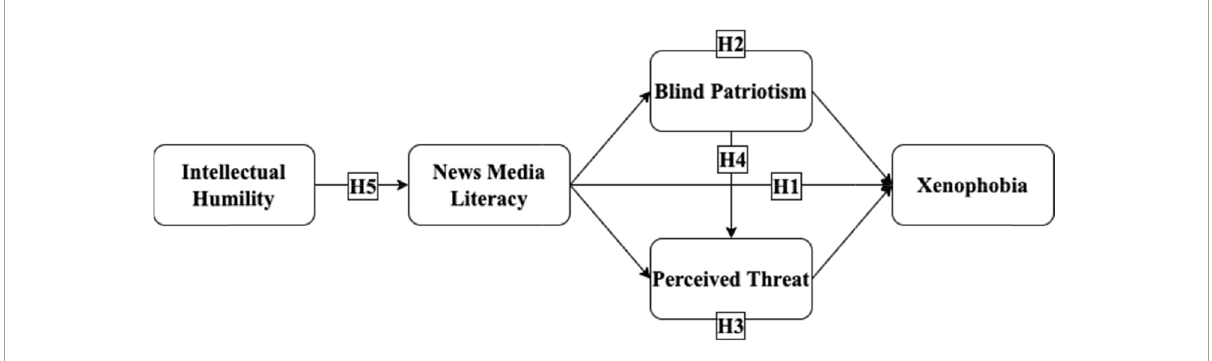
FIGURE1 The hypothesized model.